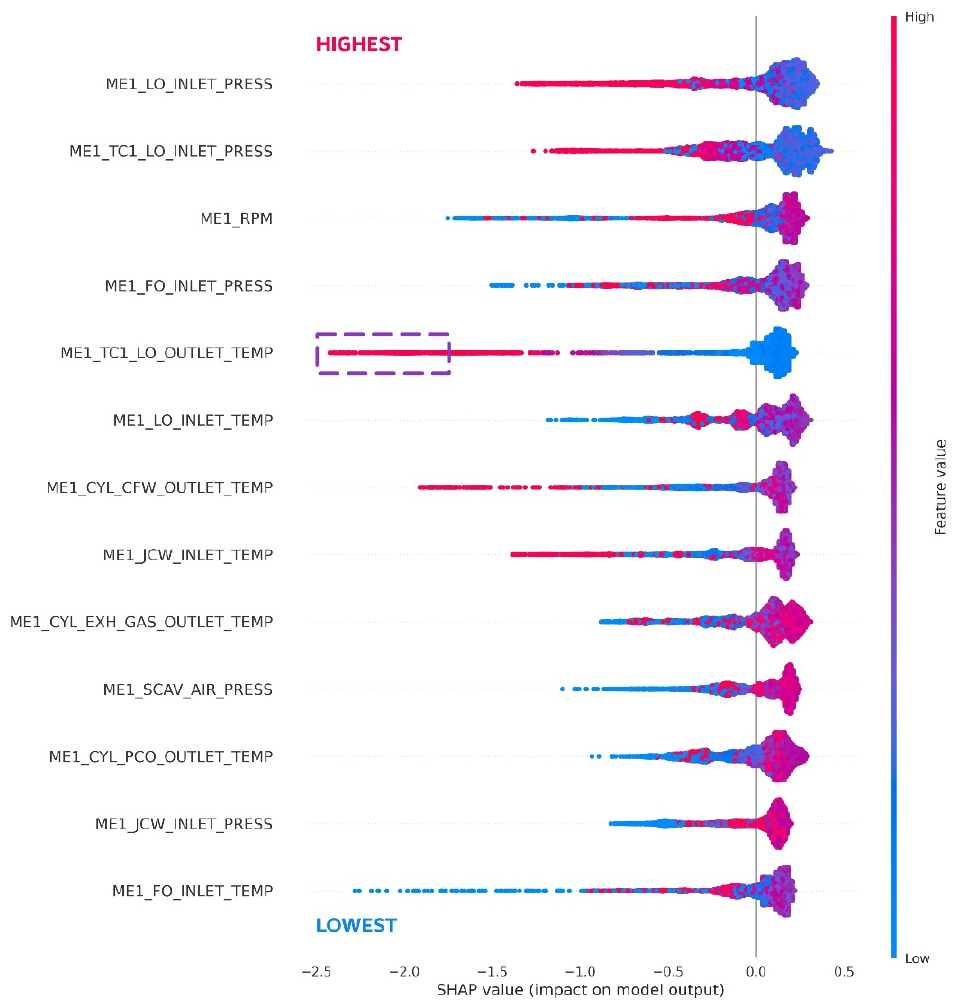
Figure 11. The distribution of SHAP values across entire data instance.